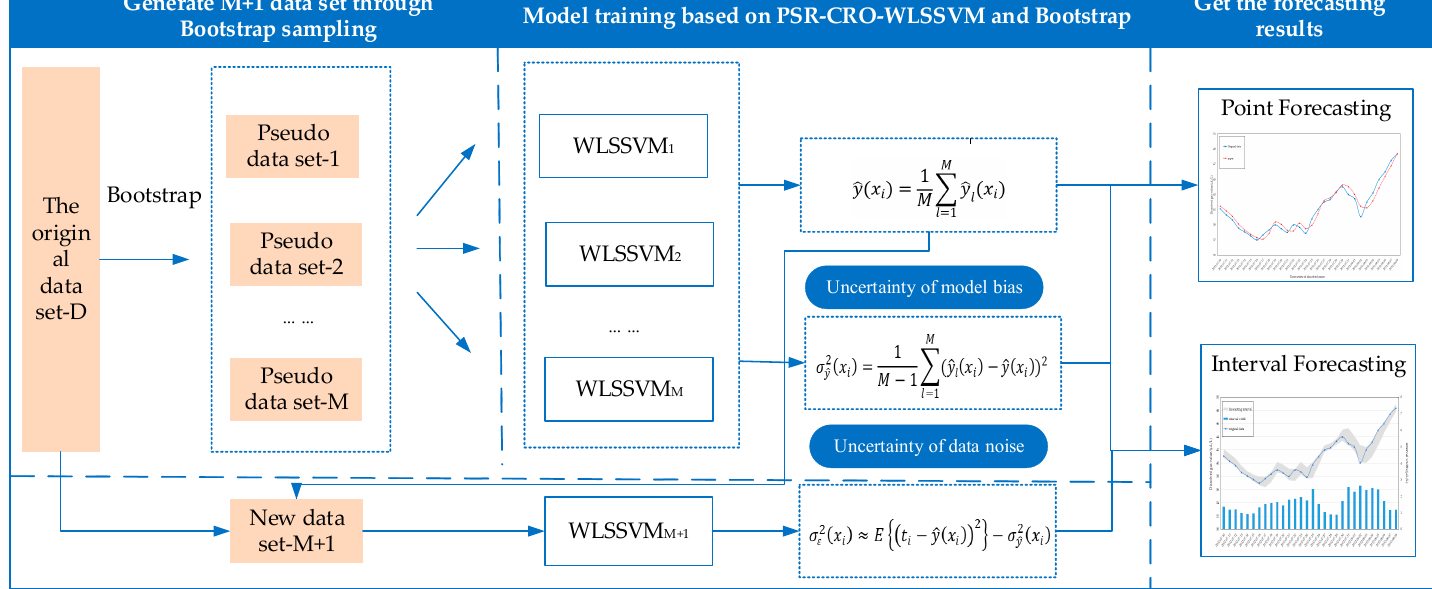
Figure 1. Interval forecasting process based on bootstrap and phase space reconstruction (PSR)-chemical reaction optimization (CRO)-weighted least squares support vector machine (WLSSVM).